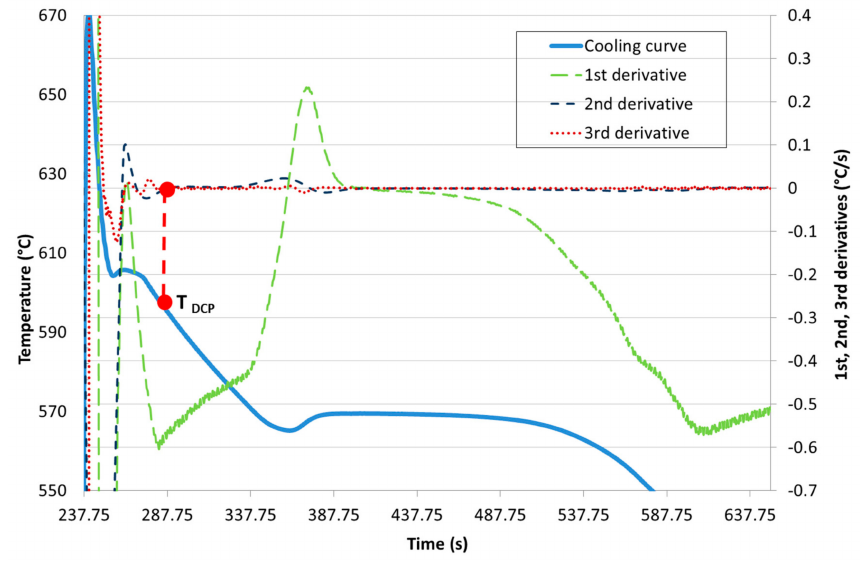
Figure 6. Method 5: the DCP determination in the crossing point of the second and third derivative in the zero axis of the dT/dt